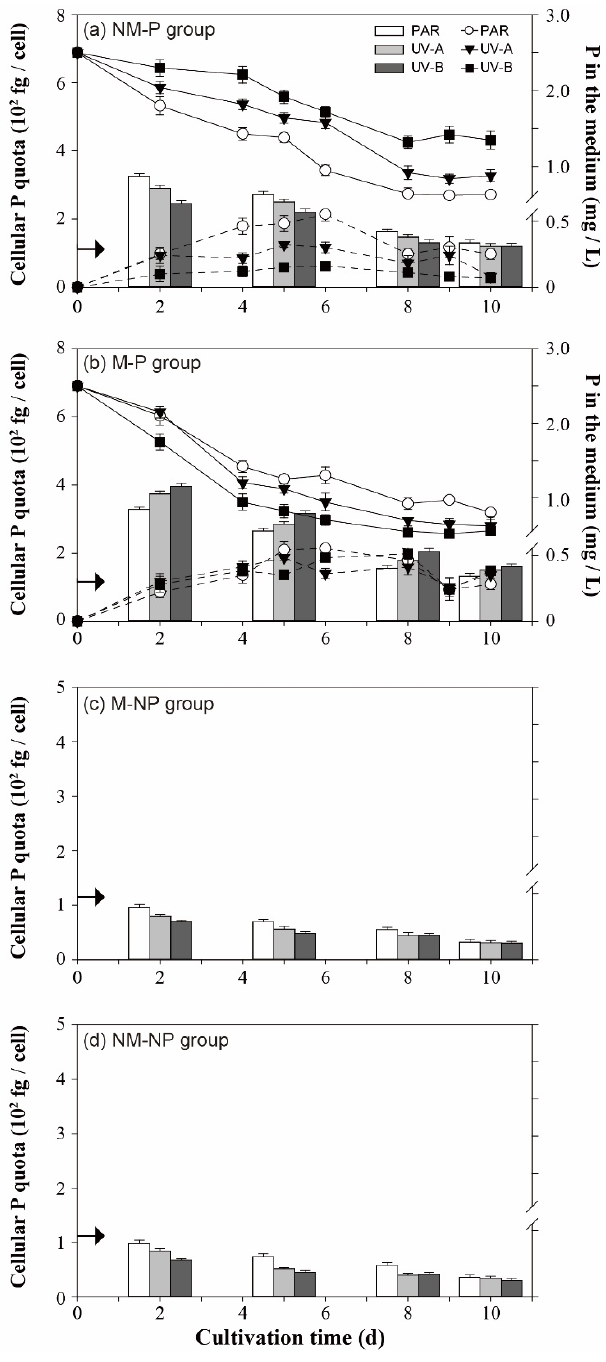
Figure 6. Cellular P quota of M. aeruginosa (vertical bar) and contents of P fractions in the medium (line and scatter, solid line referred to DOP and dashed line referred to DIP) in ( a ) NM-P group, ( b ) M-P group, ( c ) NM-NP group and ( d ) M-NP group after different irradiation treatment.